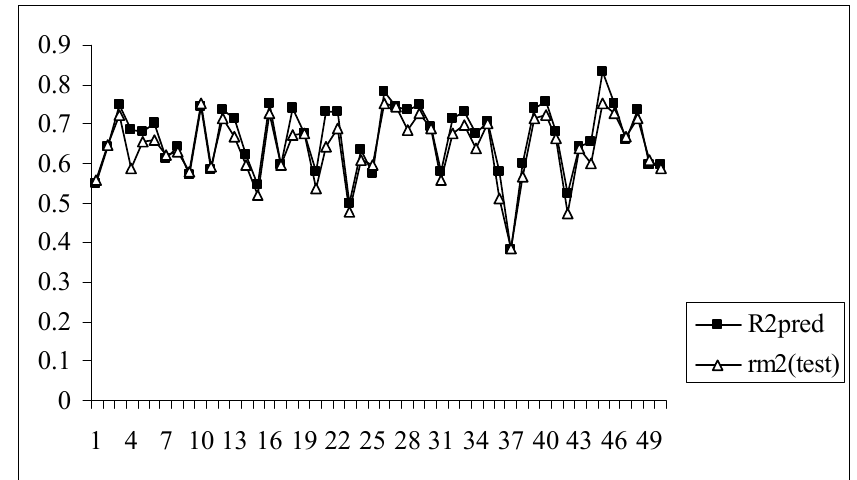
and r m2 values of 50 models (data set (test) pred